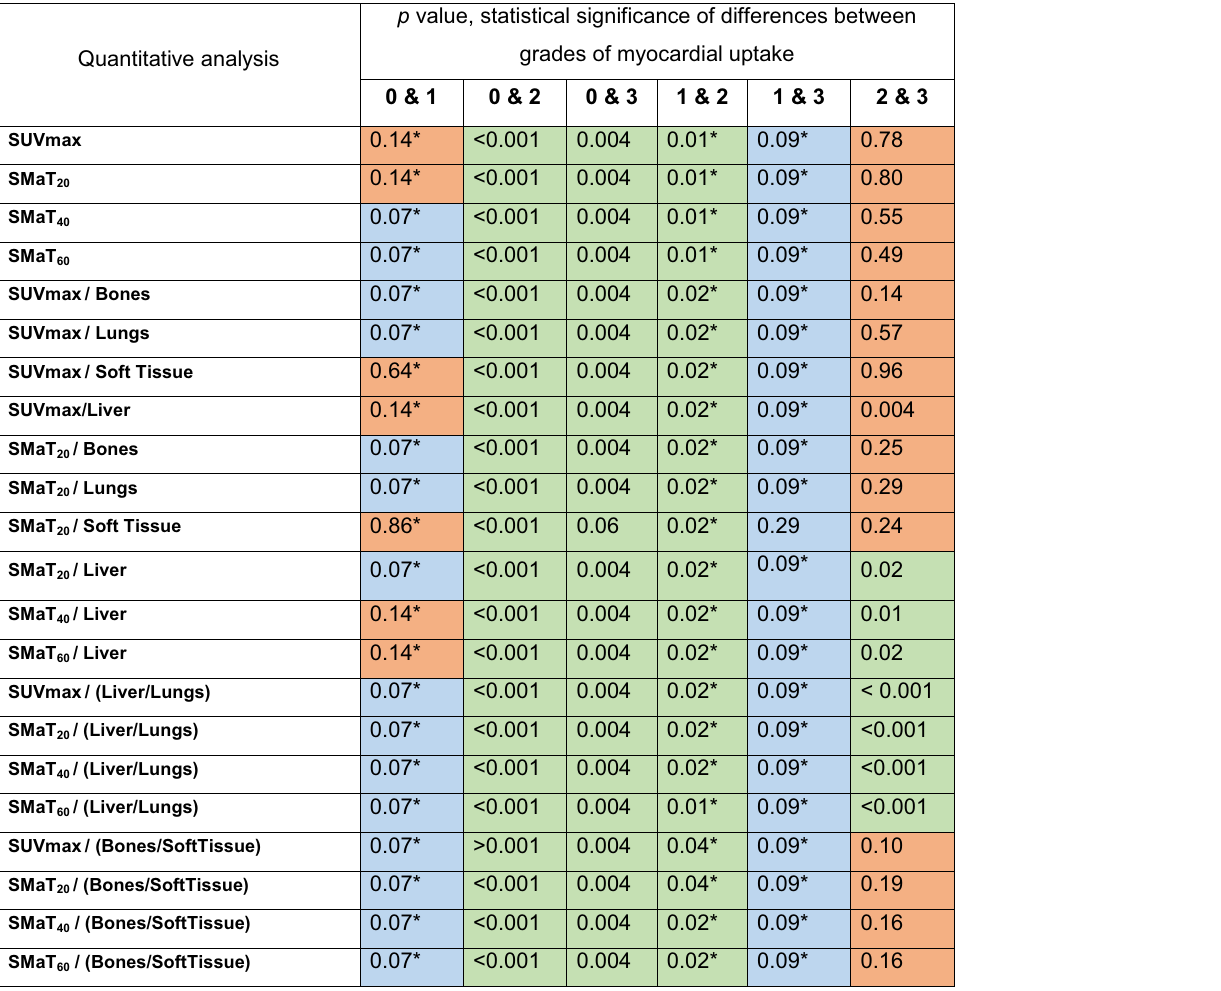
Table 3 Statistical significance of the difference in SUV values between grades of myocardial uptake p value, statistical significance of differences between grades of myocardial uptake Quantitative analysis